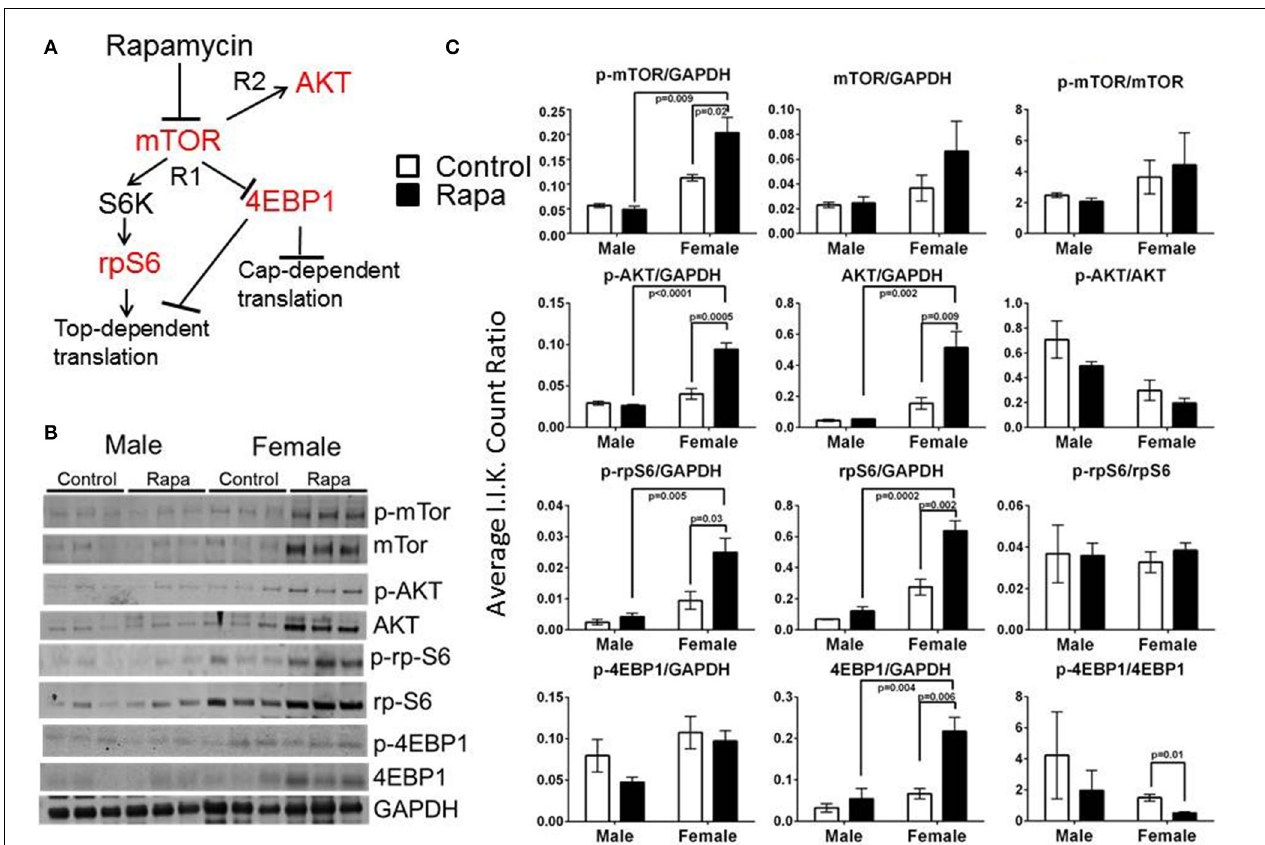
FIGURE 6 | Treatment with rapamycin altered expression of key proteins of the mTOR pathway in female brain lysates. (A) Basic schematic of the relationship of the proteins tested (highlighted in red) to mTOR (R1 indicates mTORC1-dependent branch while R2 indicates the mTORC2-dependent branch). (B) Changes in protein expression of these markers of the mTOR pathway measured in brain lysates from 25 month-old male and female mice (rapamycin-fed vs. control) and